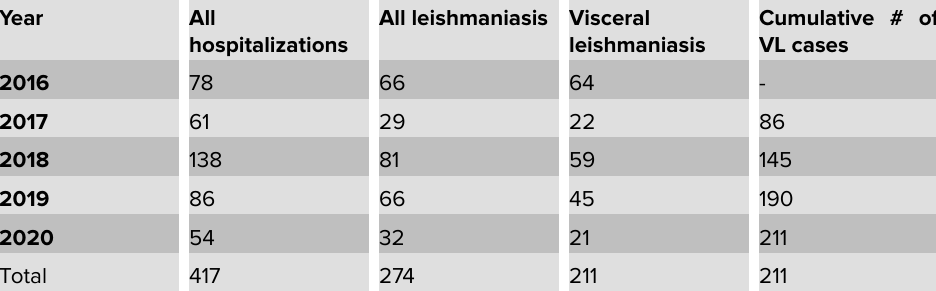
Table 5: The trend in VL admissions to the TDTH from 2016 to 2020.